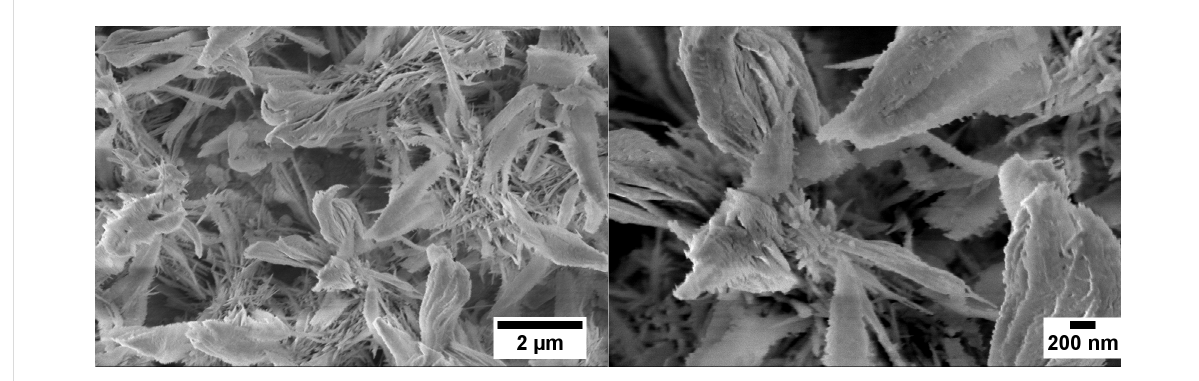
Figure 7: SEM images of Nb 2 O 5 nanoflowers at 25k (left) and 75k (right) magnification level.